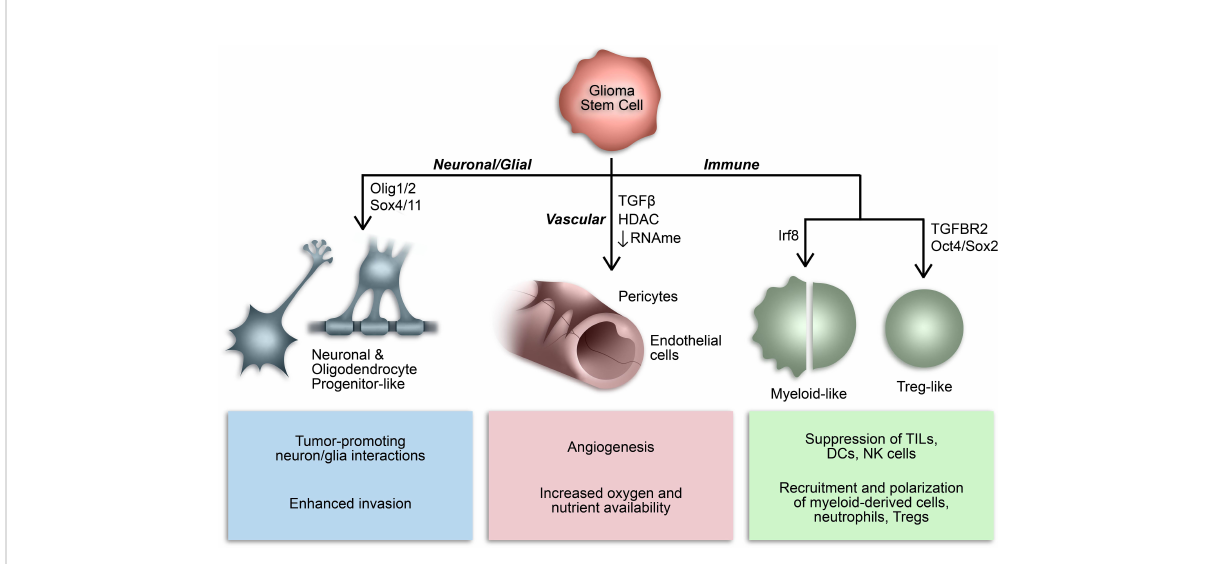
FIGURE 2 Consequences of GSC lineage plasticity. A de fi ning characteristic of GSCs is their multipotency, or ability to differentiate into various cell types within a particular cell lineage. Cancer stem cells, including GSCs, can imitate cell types from multiple lineages by co-opting their transcriptional pro fi les and consequently mimicking their functions.